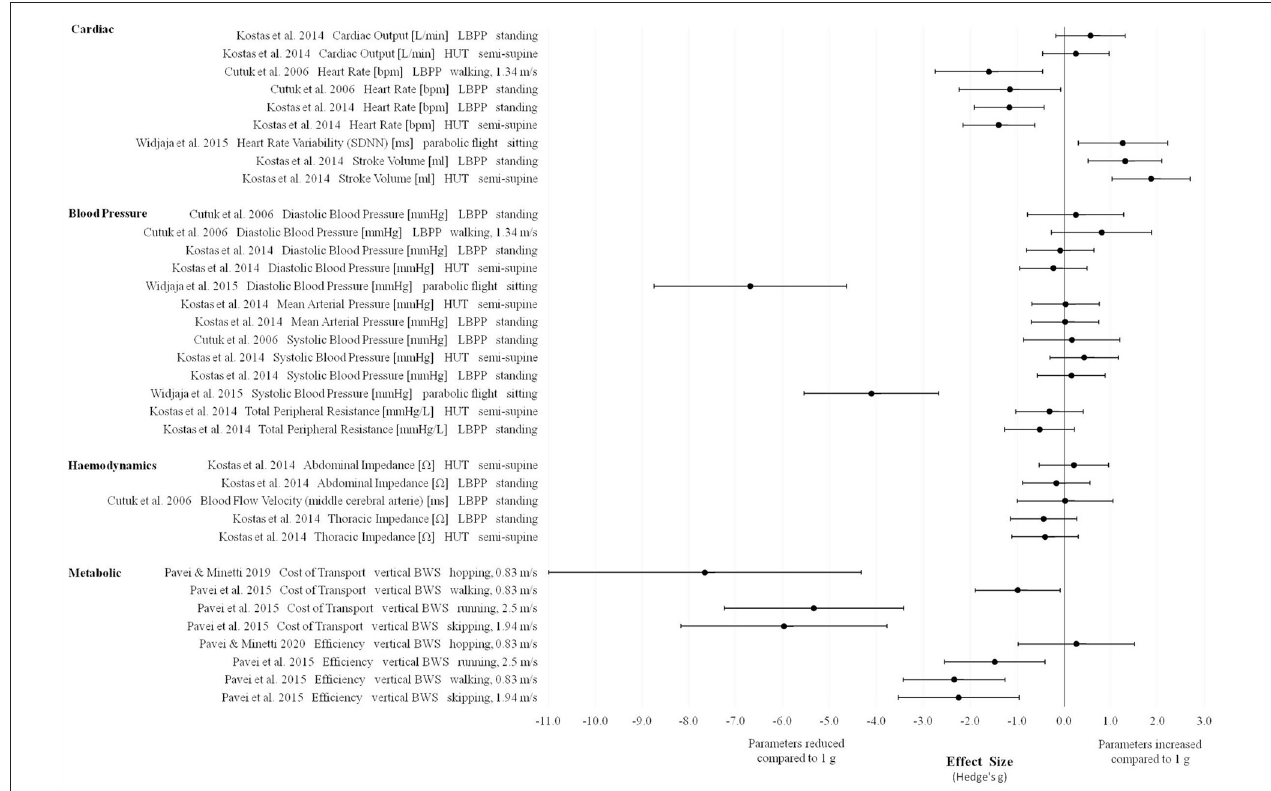
FIGURE 5 | Effect sizes (Hedge’s g) and confidence intervals for cardiopulmonary parameters in Lunar gravity compared to